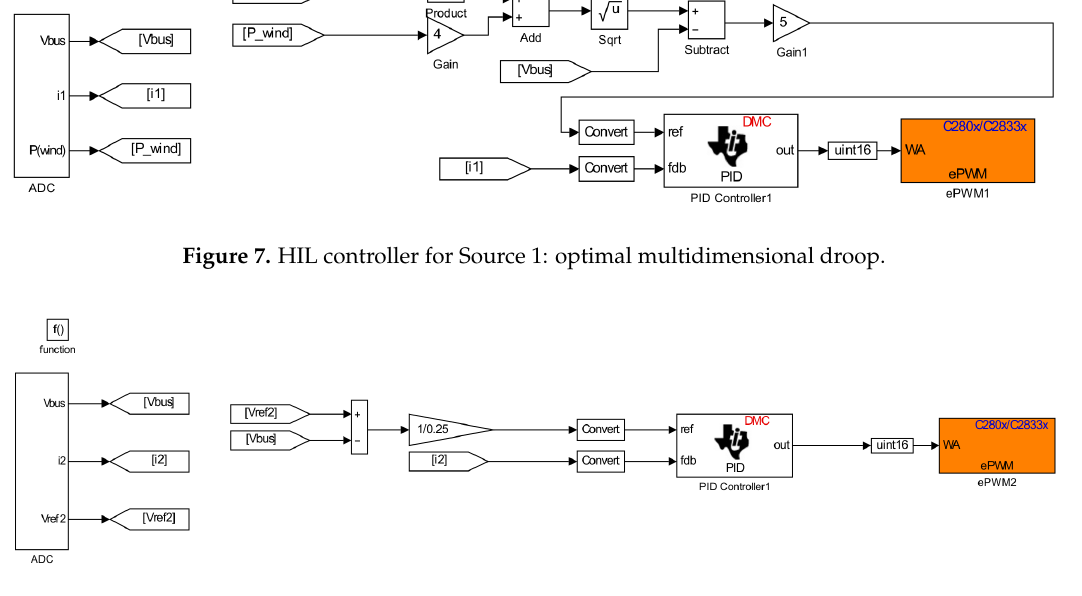
Figure 8. HIL controller for Source 2: traditional droop.